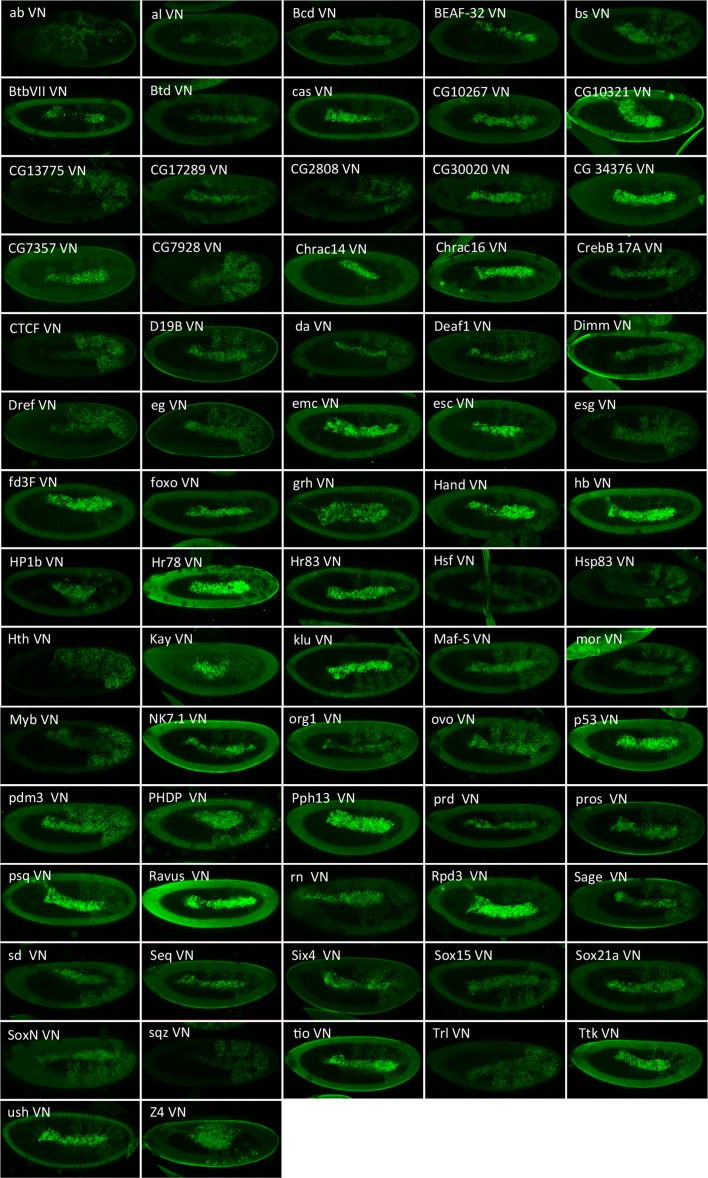
Illustrative confocal captures of Venus-based BiFC between ORF-VN and VC-AbdA, as indicated.Fusion proteins are expressed with the abdA-Gal4 driver and BiFC analysed in the epidermis of stage 10 embryos.